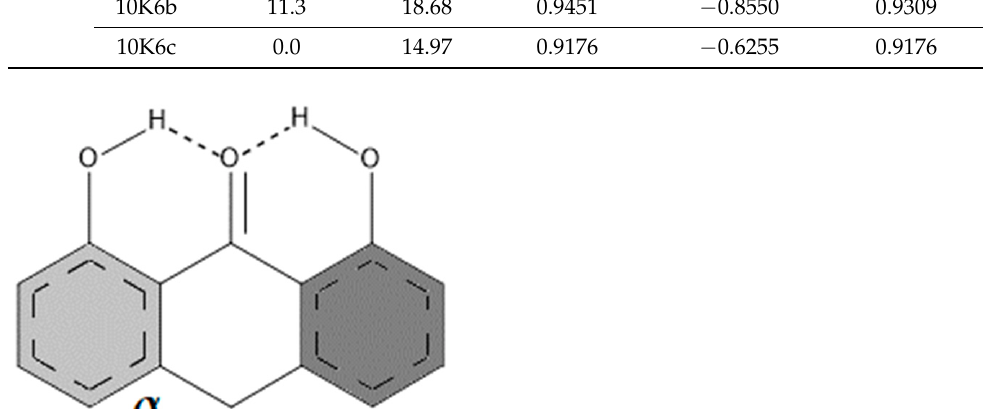
Table 2. Δ G at 298 K, α and HOMA parameter for optimized structures of enol and ketone forms. Angle defined according to Scheme 1. For each substituent, the lowest energy has been obtained for the structure in the keto form with two hydrogen